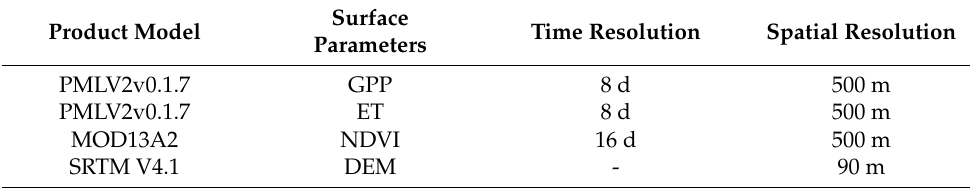
Table 1. Research data sources. Product Model